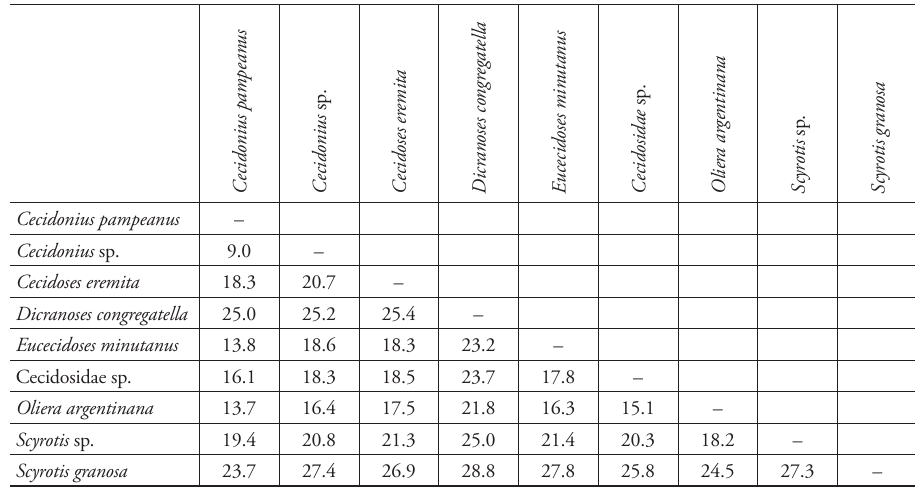
Table 1. Estimates of pairwise genetic distance (%) among nine Cecidosidae lineages based on DNA sequences (1420 base pairs of the cytochrome oxidase subunit I gene) using